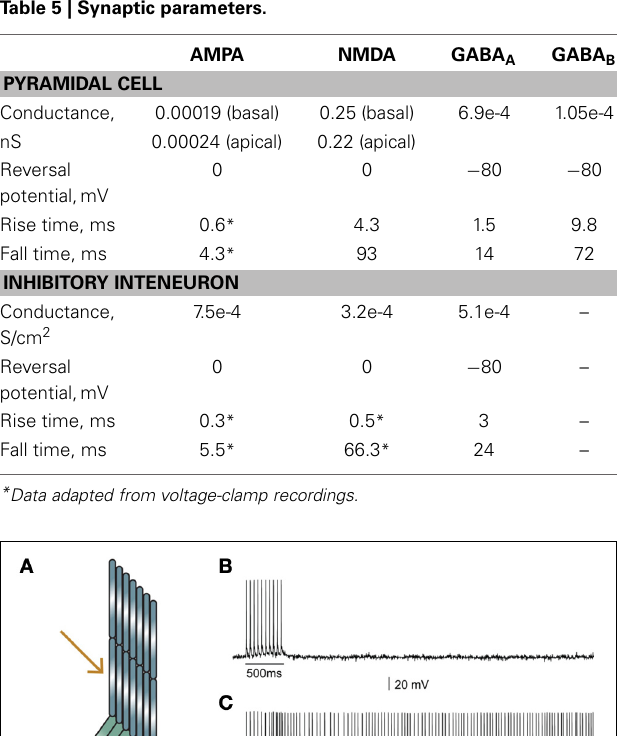
Table 5 | Synaptic parameters.